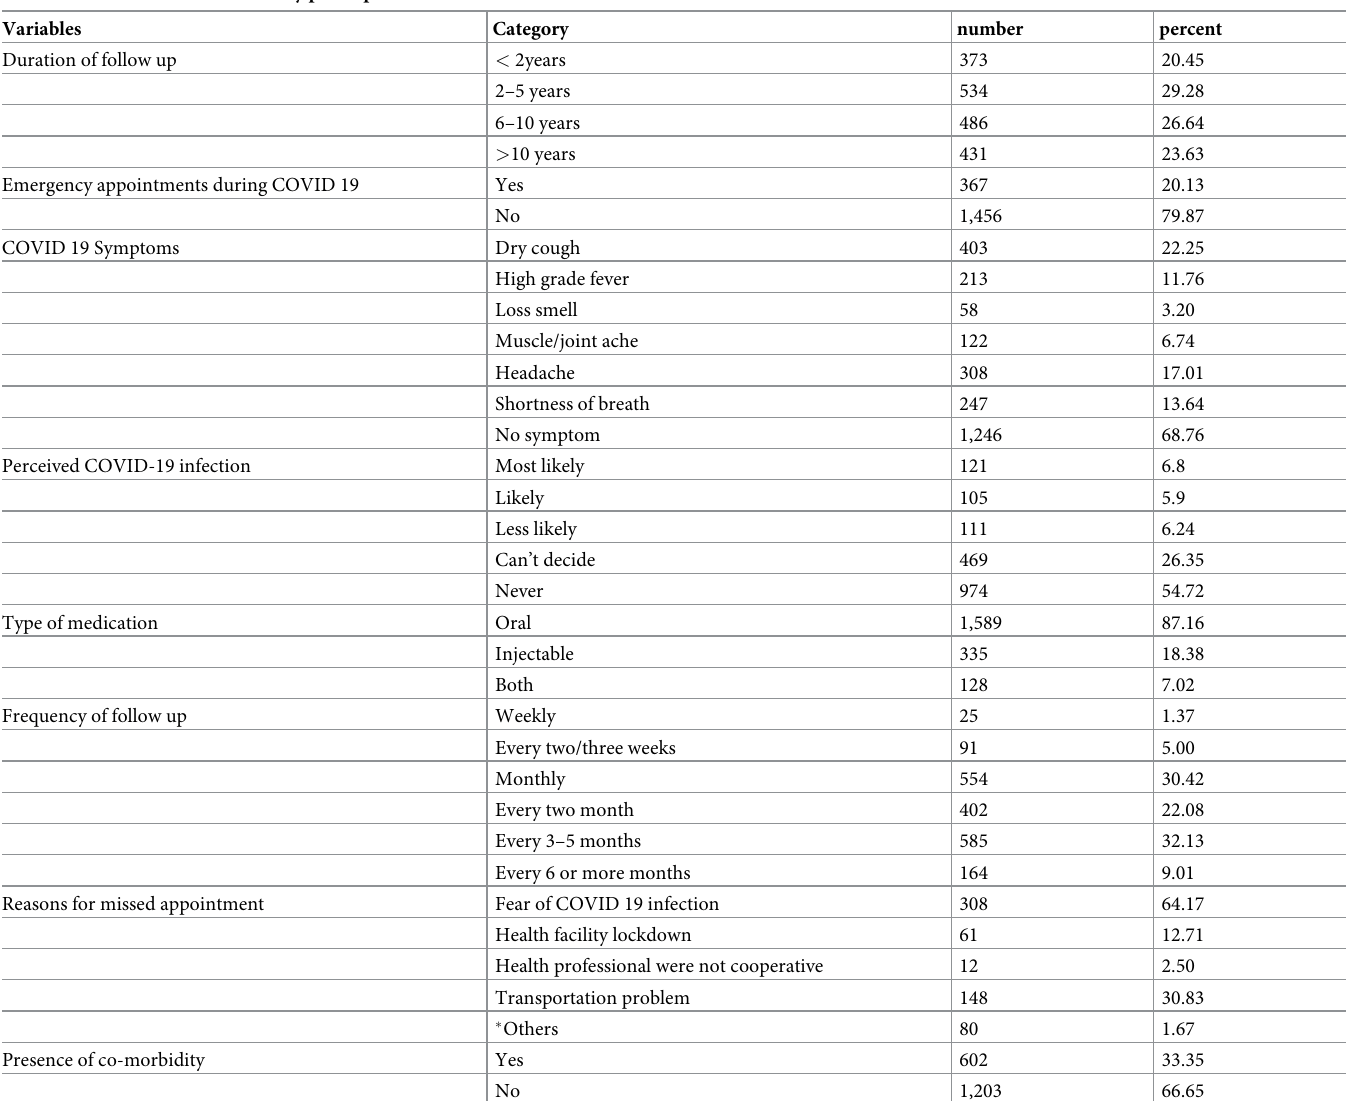
Table 2. Clinical factors of the study